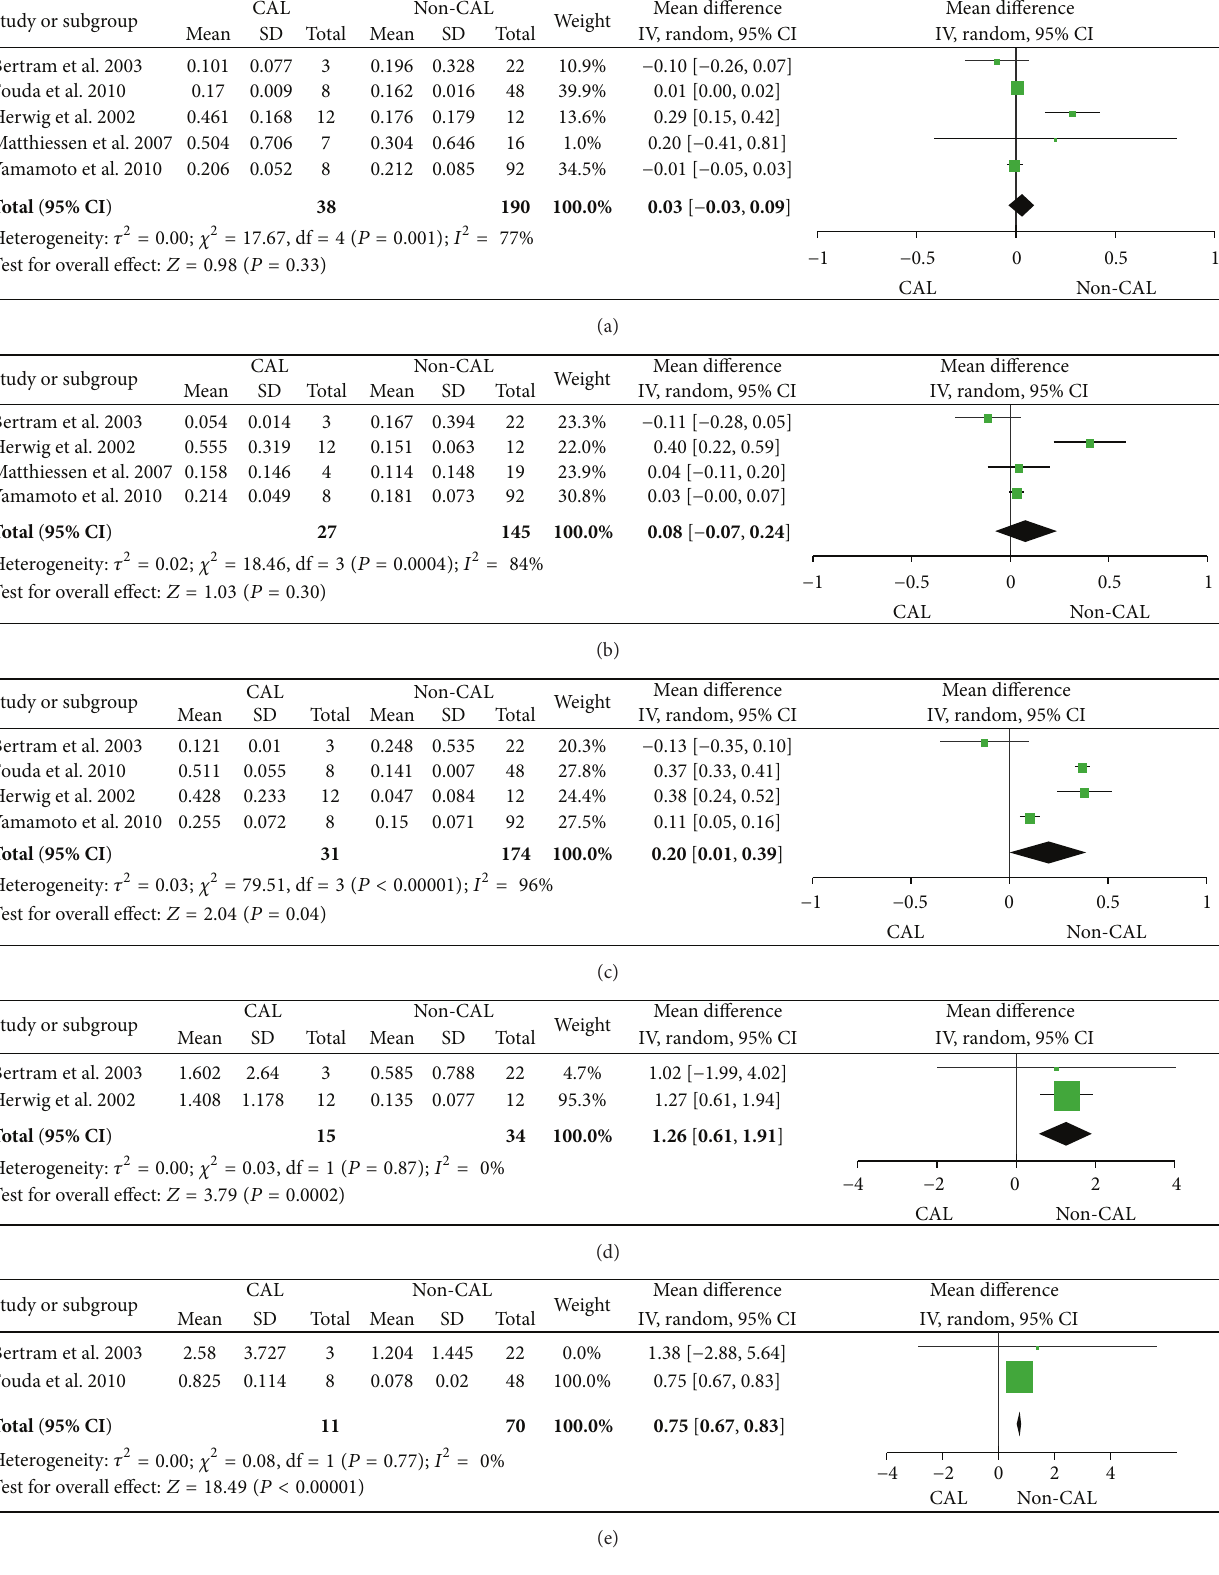
Figure 3: Forest plot with 95% confidence interval (CI) of the mean difference of peritoneal levels of TNF (ng/mL) between colorectal anastomotic leakage (CAL) patients and non-CAL patients per postoperative days (POD) 1 (a), 2 (b), 3 (c), 4 (d), and 5